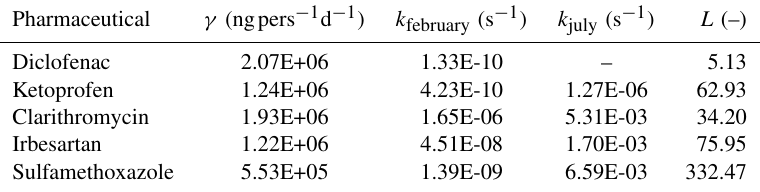
Table 4. Model M3 theoretical load coefficients ( γ ), coefficients of decay ( k february , and k july ) and L -values for the five